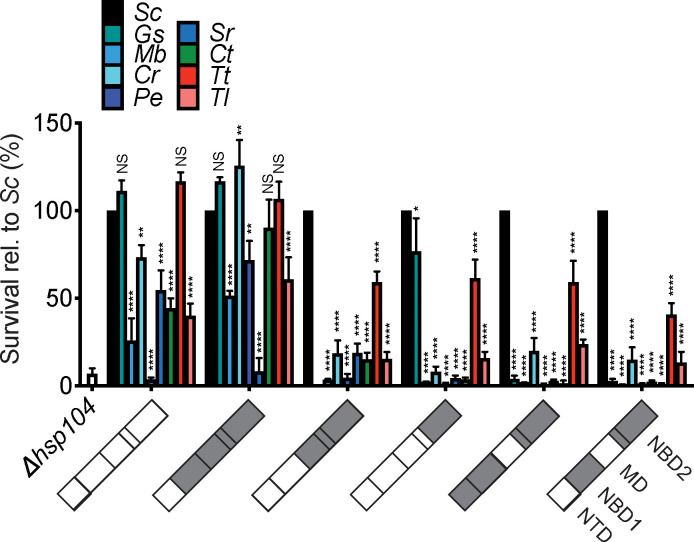
Thermotolerance activity of Hsp104 chimeras.Survival of yeast expressing GsHsp104, MbHsp104, CrHsp104, PeHsp104, SrHsp104, CtHsp104, TtHsp104, TlHsp104, or a chimera between one of these (as indicated by color in bar chart) and ScHsp104 was assessed following 20 min heat shock at 50°C. Values are relative to wild-type ScHsp104 (black bars) and represent means ± SEM (n = 3 independent transformations). Illustrations on x-axis indicate chimera composition. Gray indicates portions of the chimera from ScHsp104 and white indicates variable regions from other homologs. Two-way ANOVA with Tukey’s multiple comparisons test was used to compare was used to compare survival of strains expressing a given chimera to survival of strains expressing ScHsp104 (which was set to 100%). *p<0.05; **p<0.01; ***p<0.001; ****p<0.0001; NS, not significant.